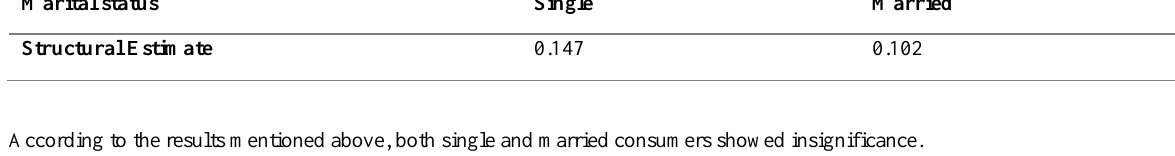
Table 9: Regression weights of the relationship among marital status, return process experience post-purchase regret at shopping malls in Sri Lanka Marital status Single Married Structural Estimate